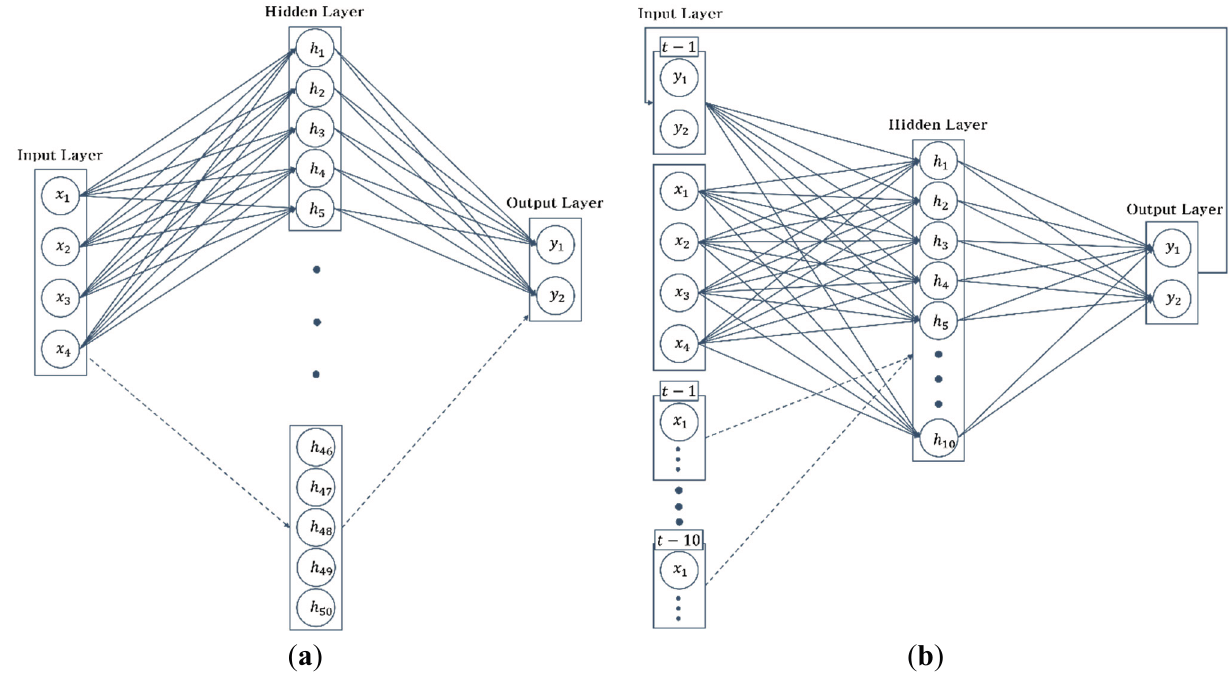
Figure 3. Growing network model (structure) of neural networks. ( a ) MLP-based network, with an increasing number of nodes in the hidden layer. The number of nodes increases from 5 to 50 nodes; ( b ) NARX-based network with an increasing number of nodes in the input layer as the input time delay increases from 1 to 10. Each input time delay has four